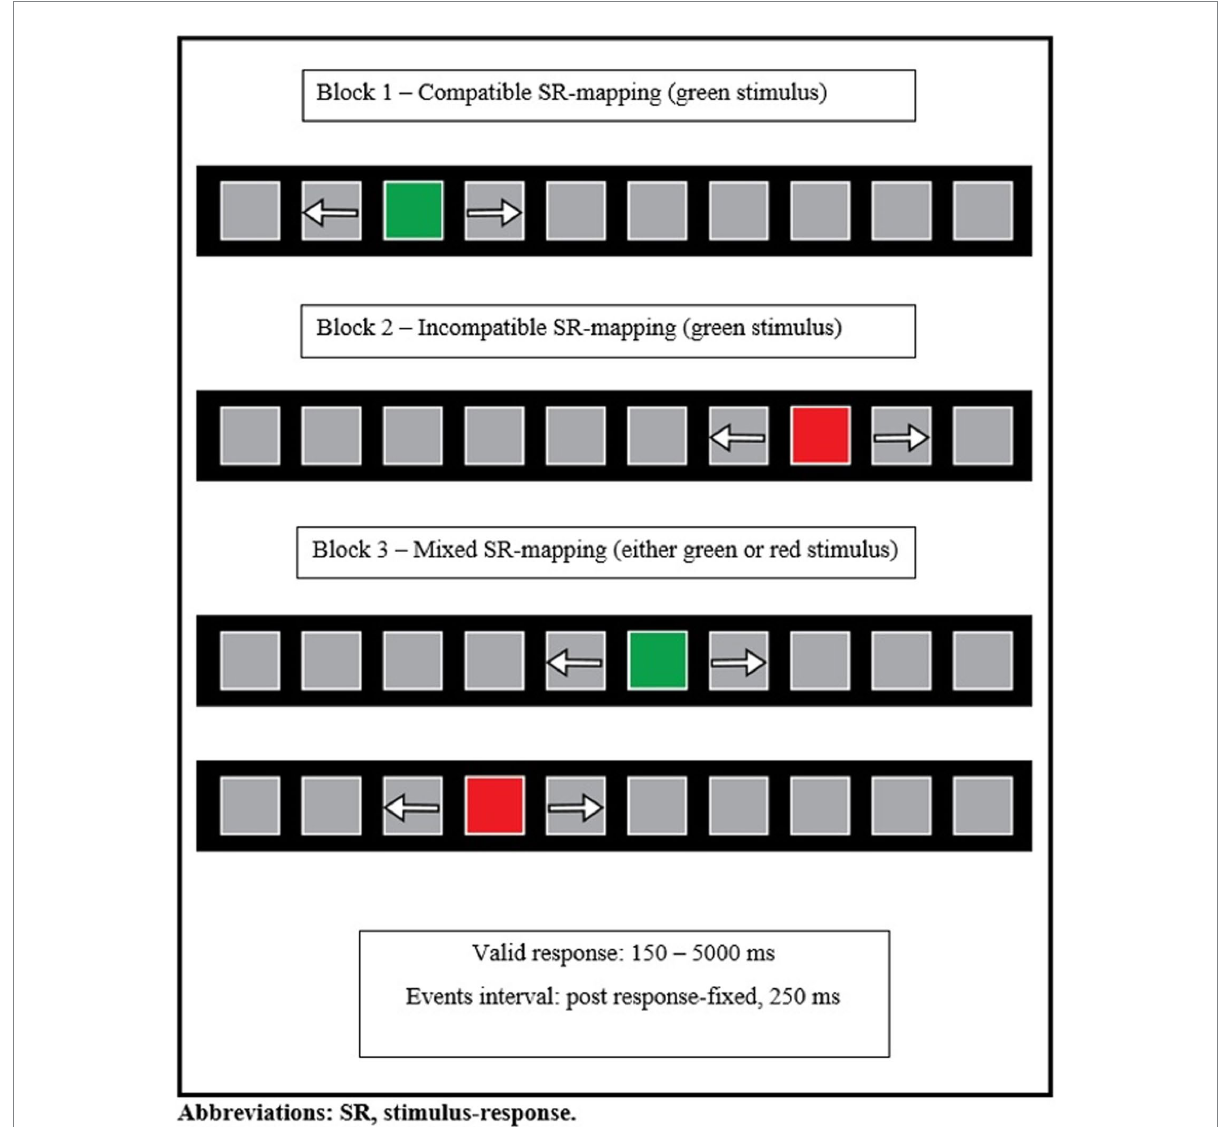
FIGURE 1 Schematic overview of the shifting attentional set-visual